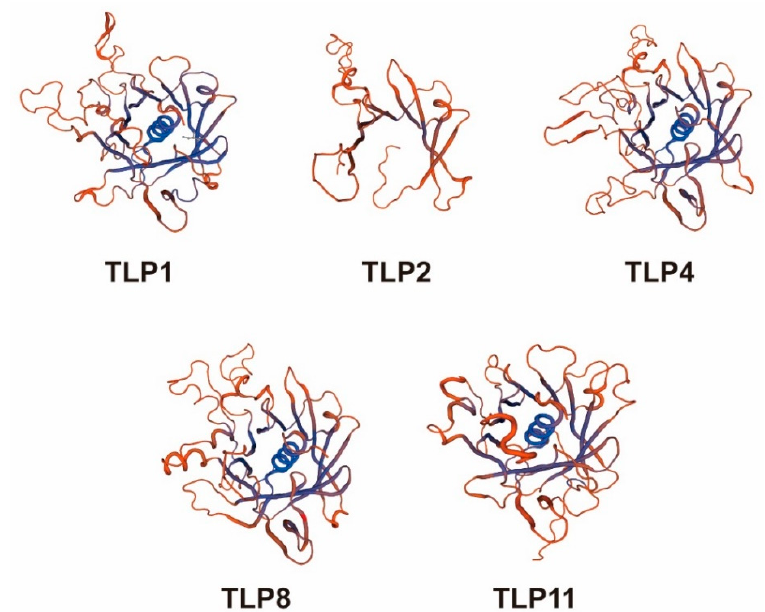
Figure 8. Three-dimensional model of TLPs in tomato .